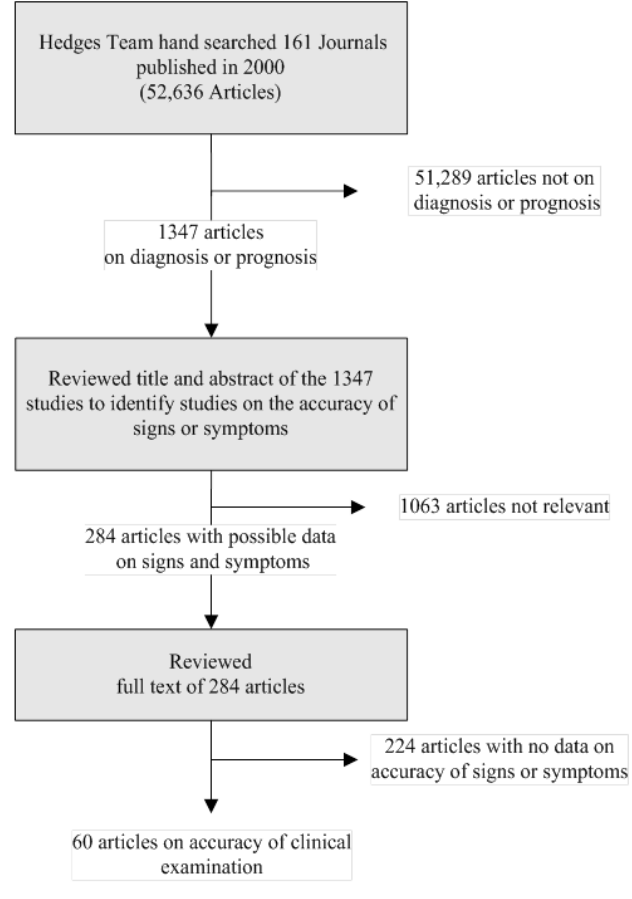
Figure 1. Flow sheet describing development of the training